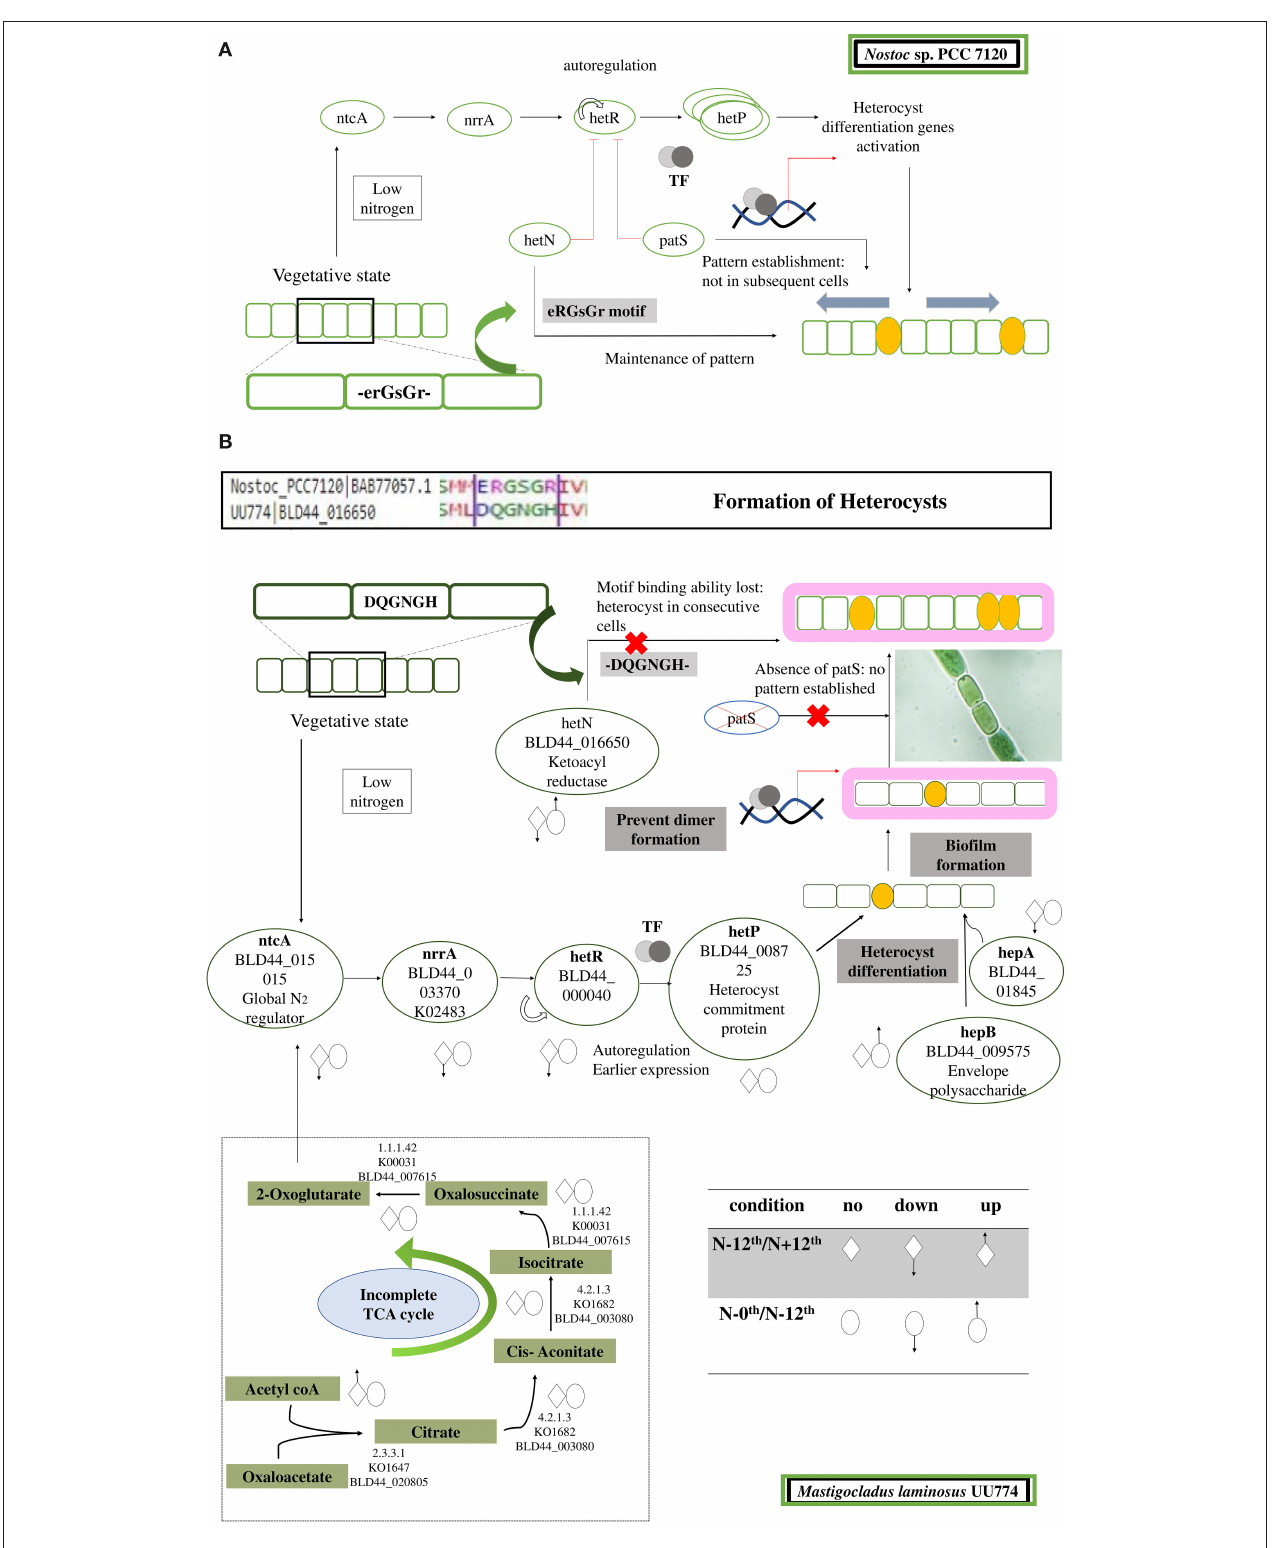
FIGURE 5 | Cartoon depicting steps leading to the formation and regulation of heterocyst formation. (A) In PCC 7120, during nitrogen step down, a rapid rate of respiration is observed, leading to accumulation of 2-OG. Sensing 2-OG accumulation, a global nitrogen regulator ntcA signals a nitrogen response regulator NrrA that subsequently signals HetR. HetR is a master transcription regulator and is auto-regulated. In addition, there are few other disrupters of HetR that prevent the